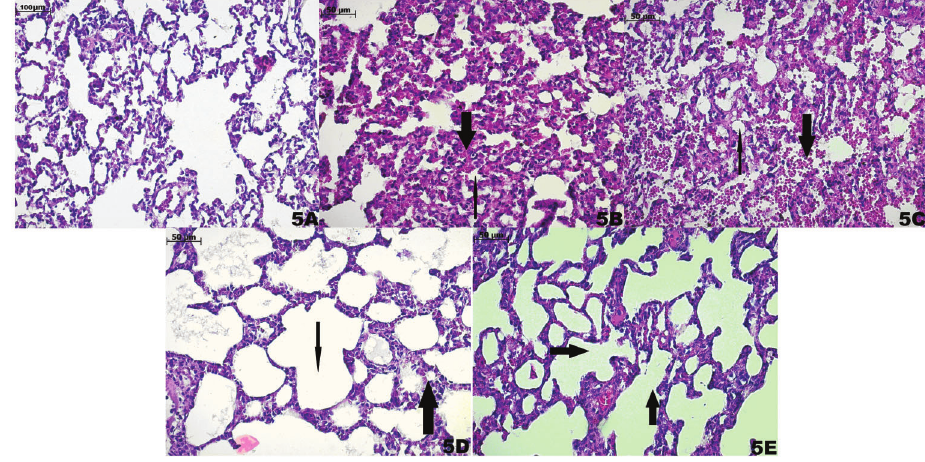
Figure 5. Histopathological findings of the groups. A , Normal lung parenchyma in the control group [hematoxylin-eosin (HE), 100X]. B , Alveolar area reduction (thin arrow) and alveolar hemorrhage (thick arrow) in radiation-treated group at 6 h (HE, 200X). C , Severe alveolar hemorrhage (thick arrow), alveolar area reduction (thin arrow), interstitial congestion, and edema in the radiation-treated group at 72 h (HE, 200X). D , Reduced interstitial congestion and alveolar hemorrhage (thick arrow) and expanded alveolar area (thin arrow) in ozone-treated groups at 6 h (HE, 200X). E , Clearly reduced interstitial congestion and alveolar hemorrhage and re-established alveolar structure (arrows) in ozone-treated groups at 72 h (HE,